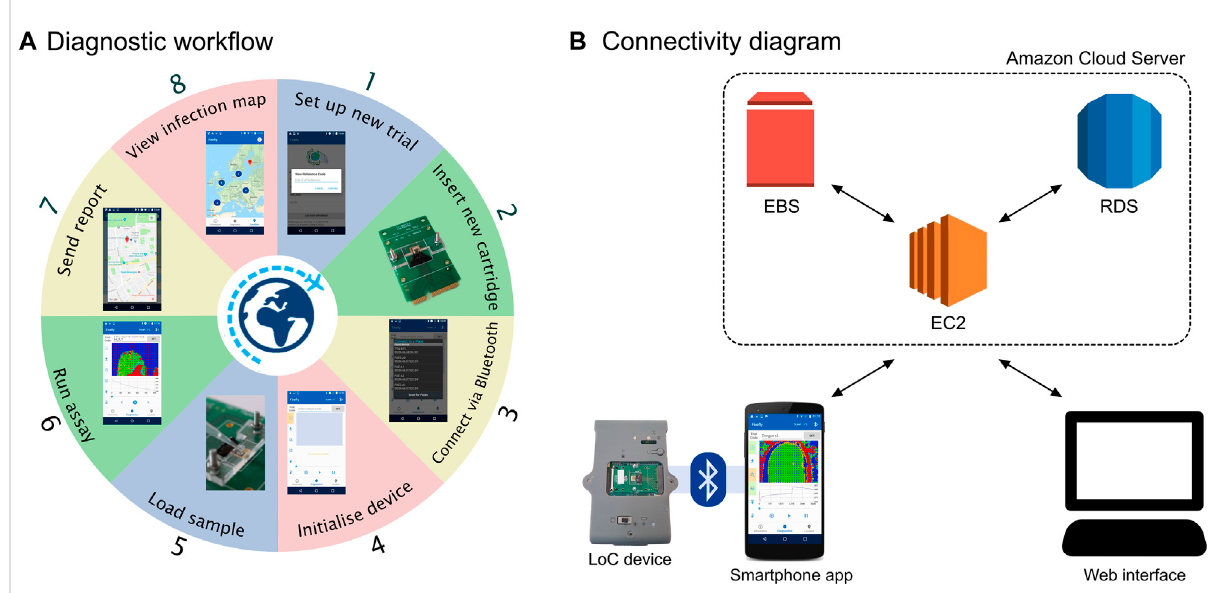
FIGURE 2 Overviewofthesmartphonesetup. (A) Diagnosticwork fl owinvolvingtheLacewingplatformandtheFire fl yapp. (B) Diagramoftheconnectivity structure between the Fire fl y app, the AWS cloud server and the web